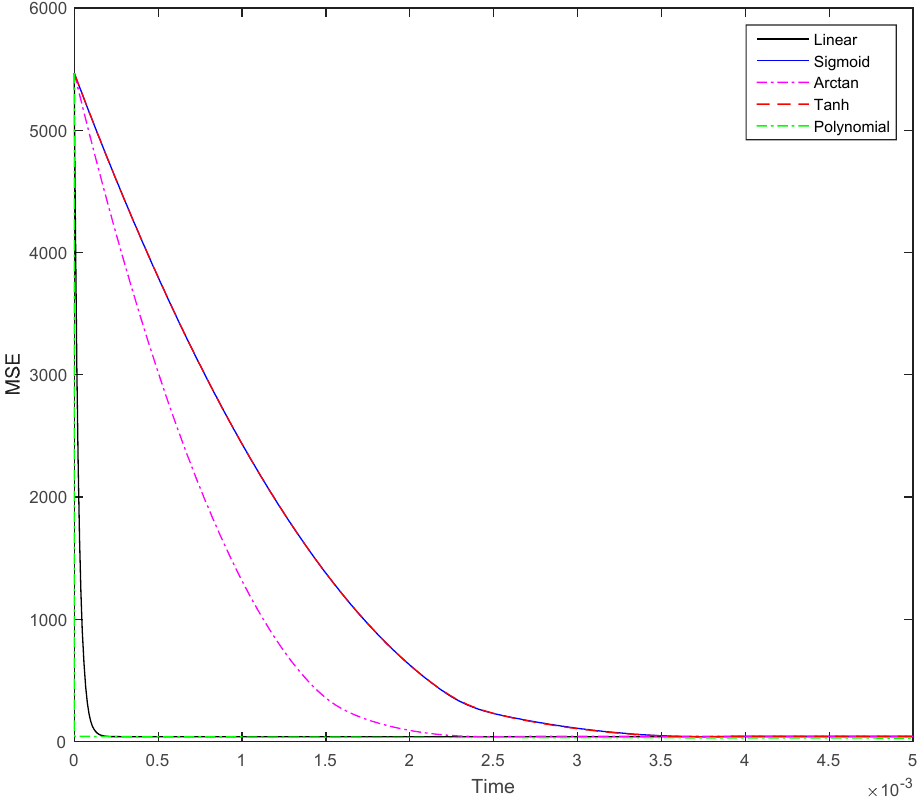
Figure 6. Showing di ff erences in convergence speed while considering di ff erent function types for F in Equation (31). Please note that n is 3 for the polynomial function F.